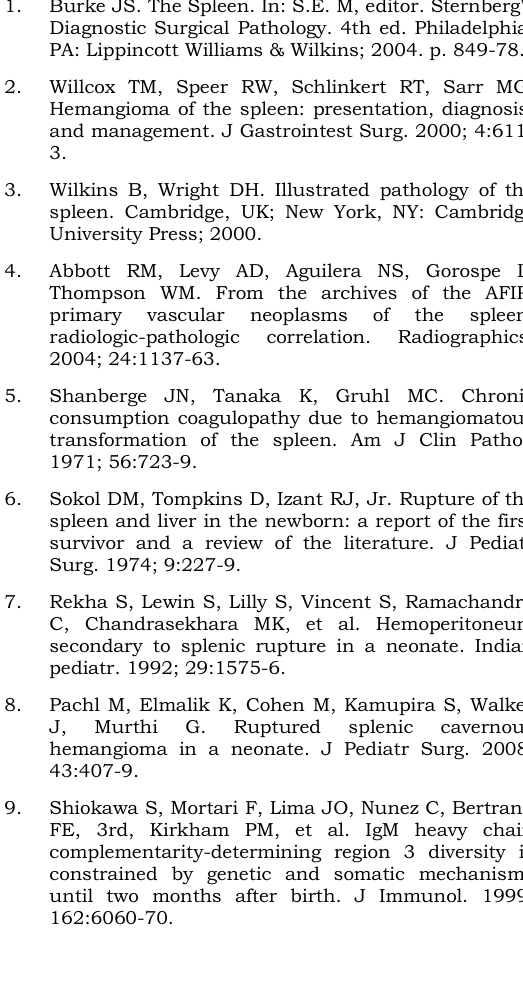
Figure 2: Hematoxylin and eosin slide showing cavernous